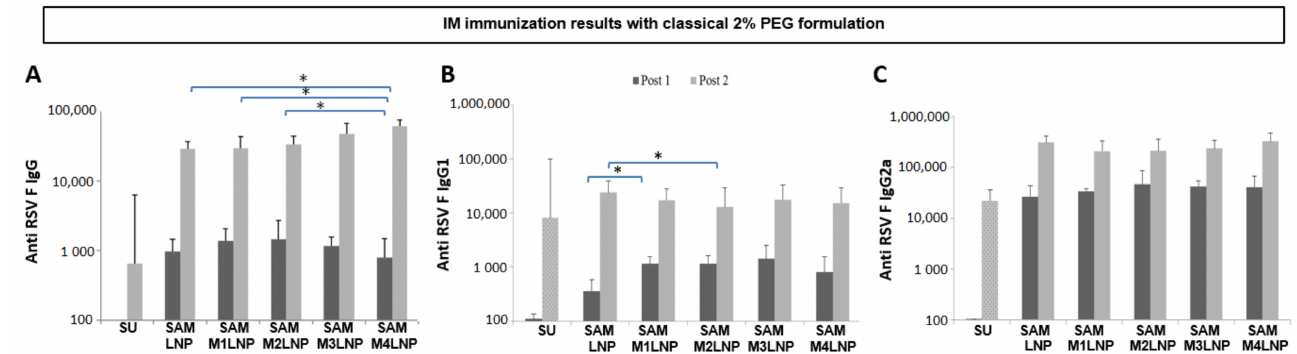
Figure 3. Immunization titers of RSV F SAM antigen formulated with classical 2% PEG LNP and MLNP formulations and administered through IM route. Median IgG ( A ), IgG1 ( B ), and IgG2a ( C ) titers, considering non adjuvanted subunit (SU) group as control. * p < 0.05 ( n = 10).